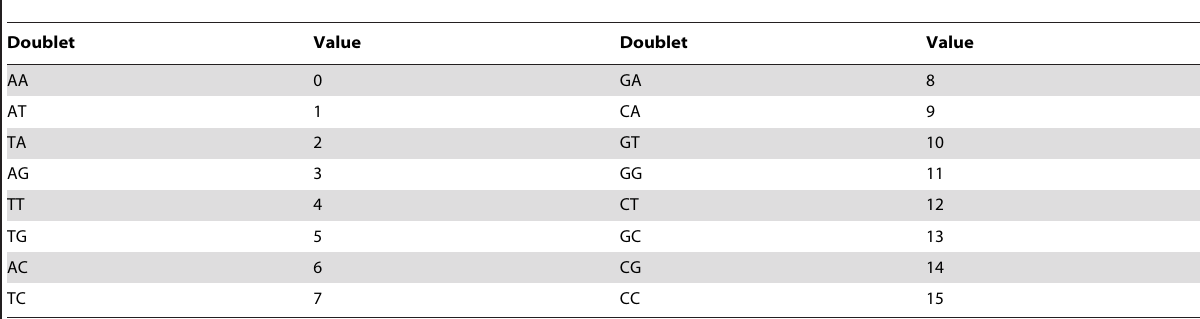
Table 1. Values employed for DNA sequence-to-signal mapping.